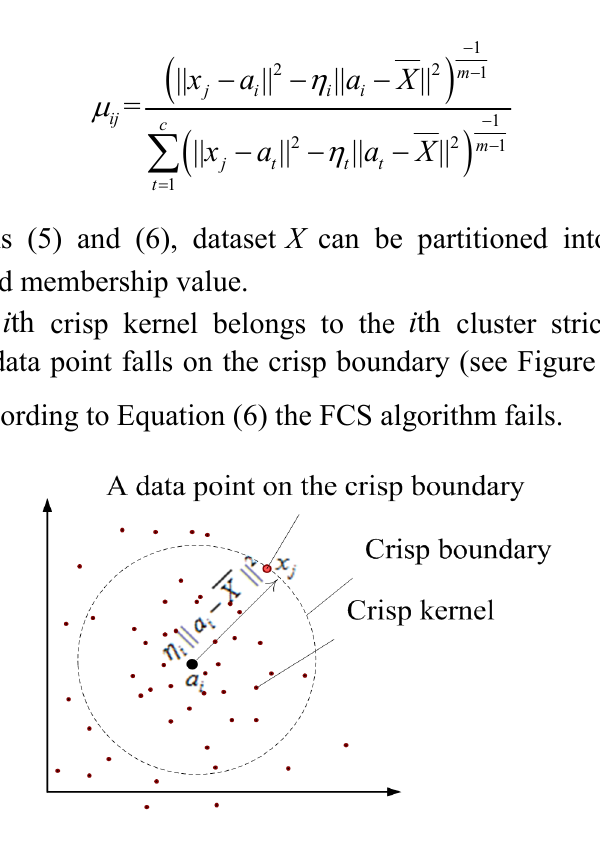
Figure 1. Illustration of the crisp